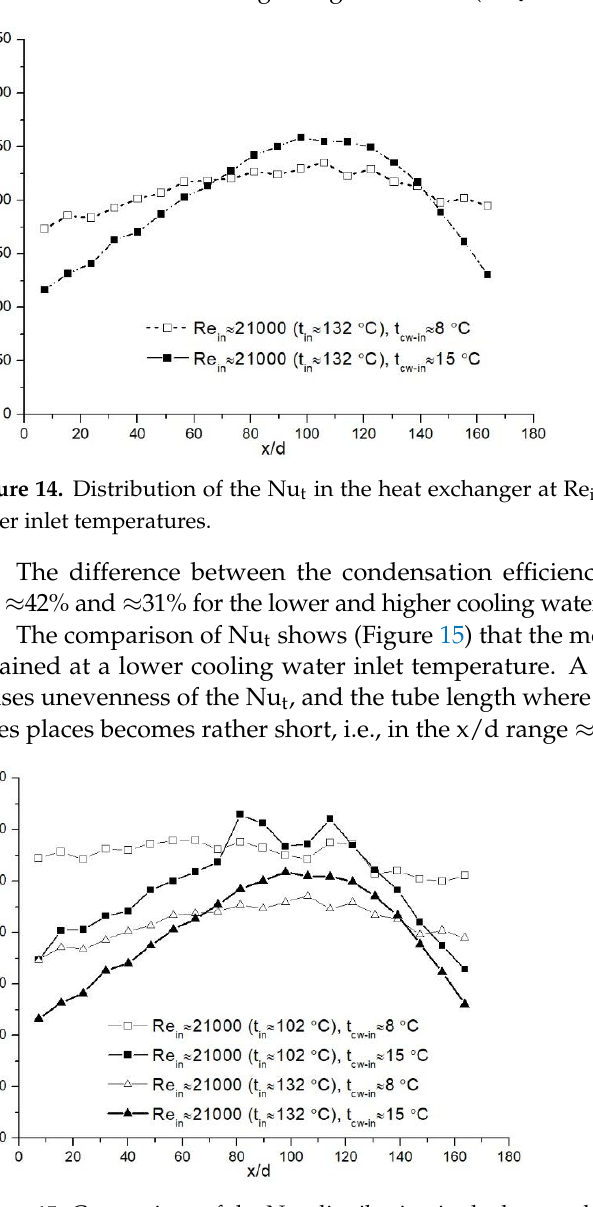
Figure 15. Comparison of the Nu t distribution in the heat exchanger at Re in ≈ 21,000, at different flue gas inlet and cooling water temperatures.